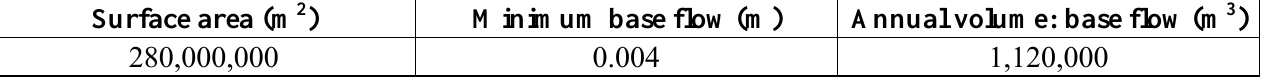
Table 4. Required base flow calculation for VDWHS.